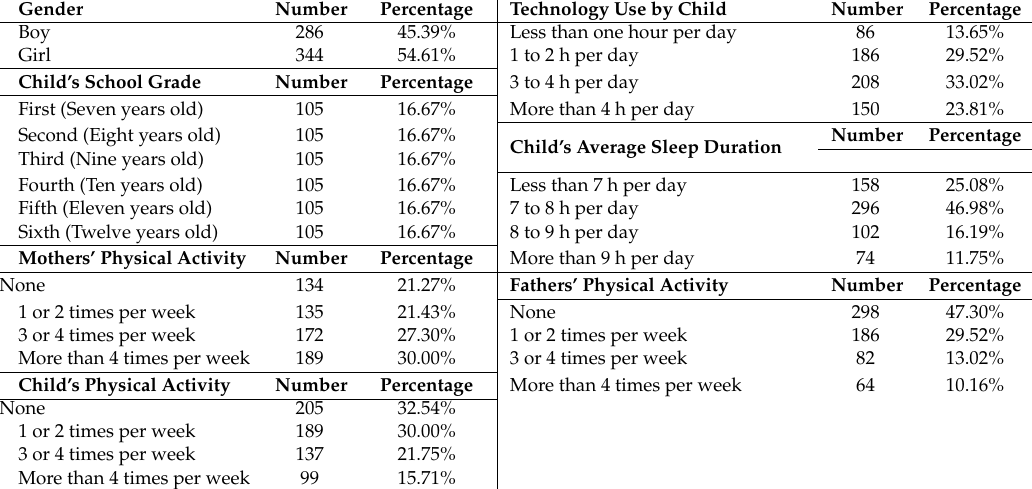
Table 4. Descriptive statistics of the control variables in the